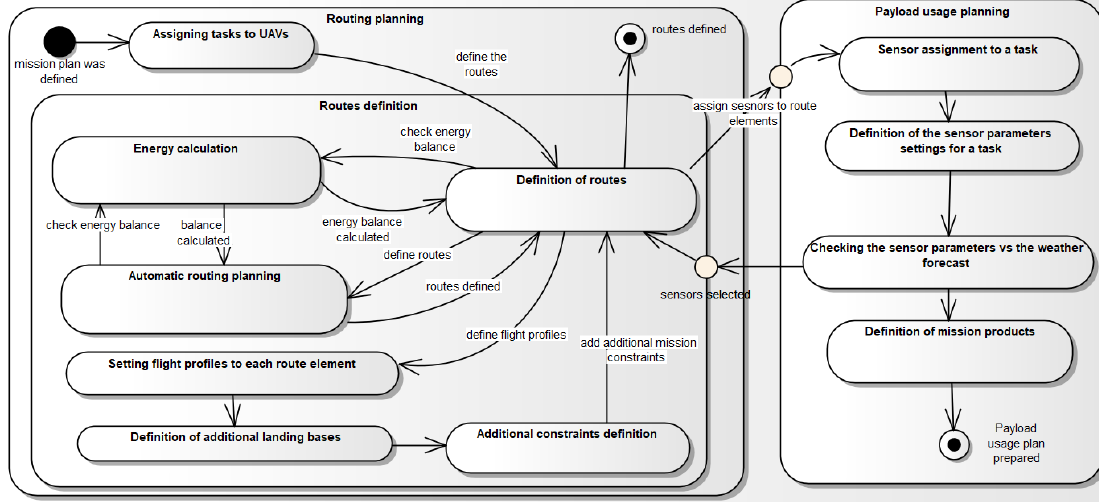
Figure 1. Mission planning